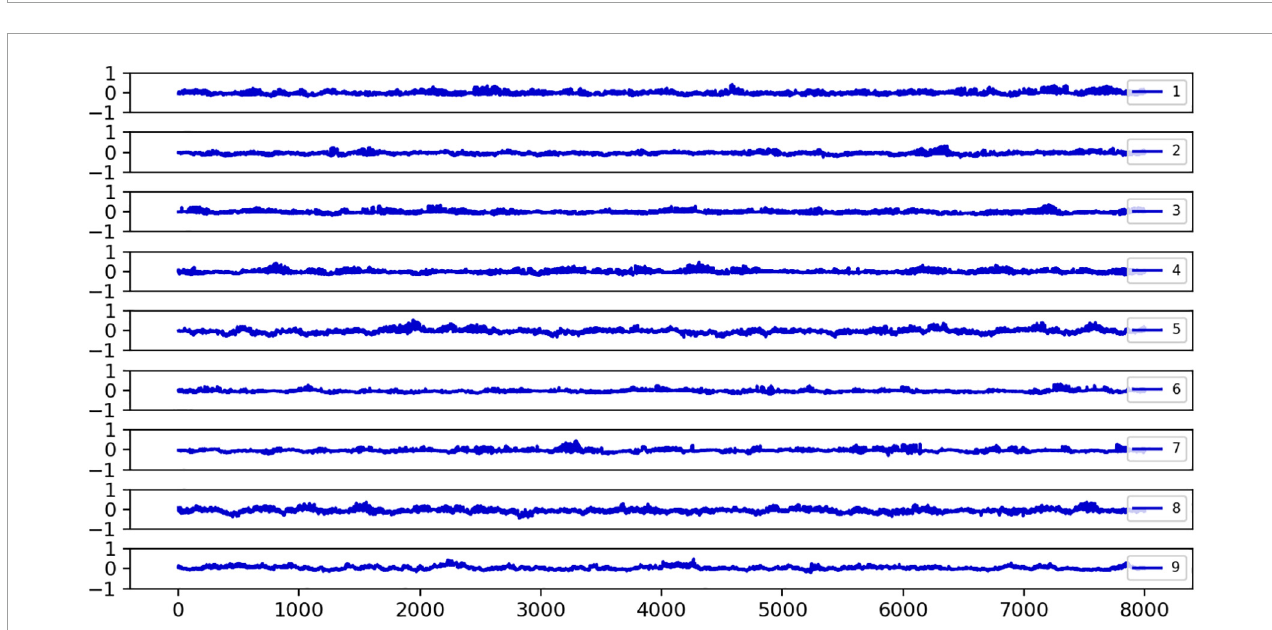
FIGURE3 The fluctuations of the H sb index over time for nine healthy subjects are plotted. H sb refers to the sub-steady-state equilibrium evaluation index of slow global oscillations relative to strong local oscillations. If H sb = 0, the two are in sub-steady state equilibrium; if H sb < 0, the network state is more skewed toward strong local oscillations; and if H sb > 0, slow global oscillations are more robust in the network. Independent of time, it was noted that the distribution of H sb in healthy participants centered around 0. Each subplot’s legend numbers reflect the number of healthy subjects, the horizontal axis is the time series t , and the vertical axis is the H sb size, normalized to the interval [− 1 , 1 ] .